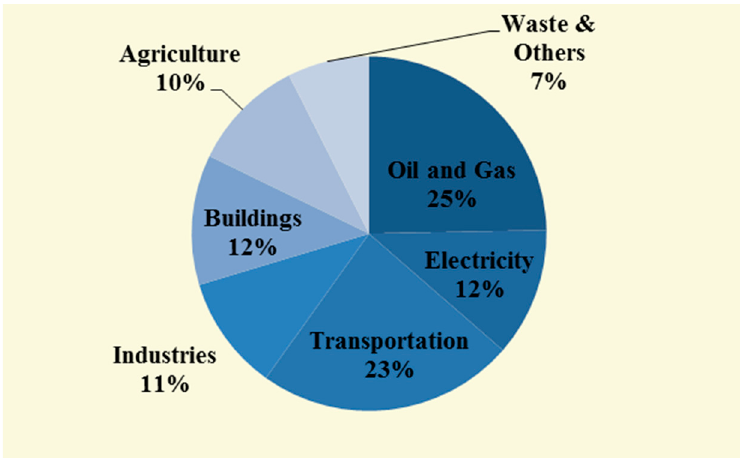
Figure 1. Canada carbon dioxide emissions by source in 2013 [1].